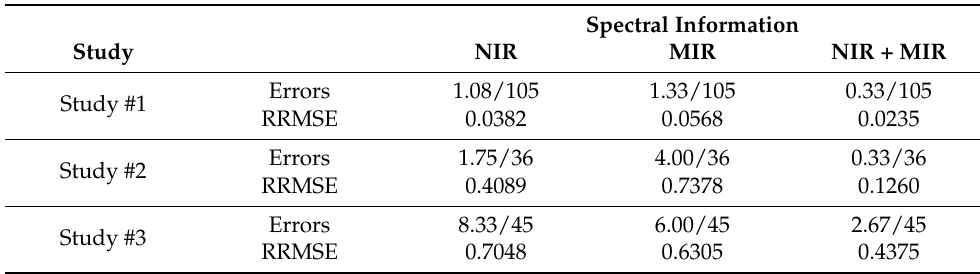
Table 13. Summary of the Results Attained in the Three Studies from the NIR, MIR and NIR + MIR Spectral